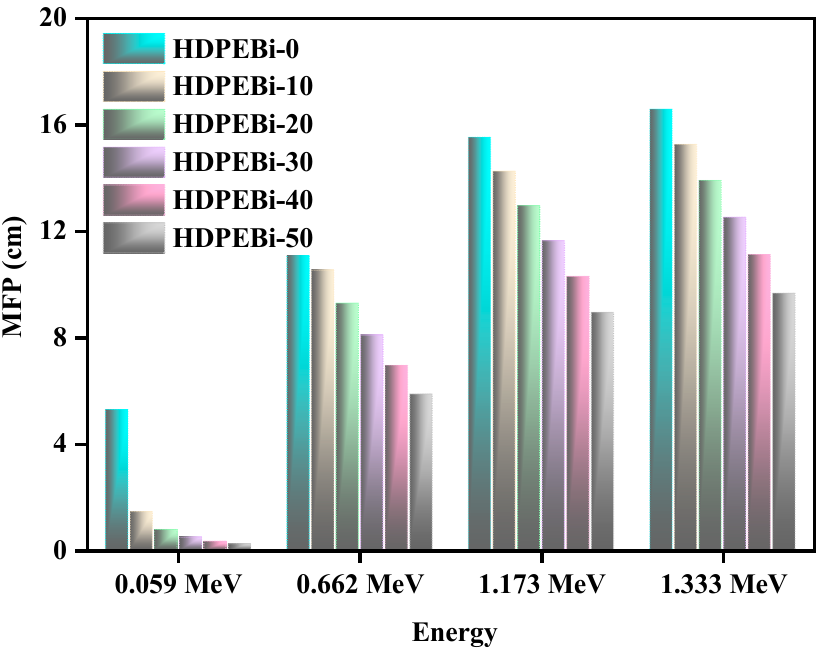
Figure 7. Mean free paths for all prepared samples at different energies. Figure 8. Mean free paths for all prepared samples at different